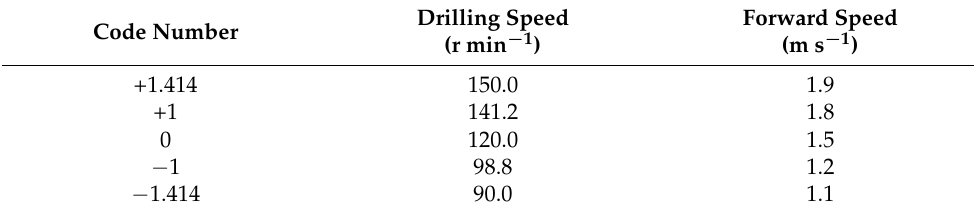
Table 3. Coding table of level of experimental